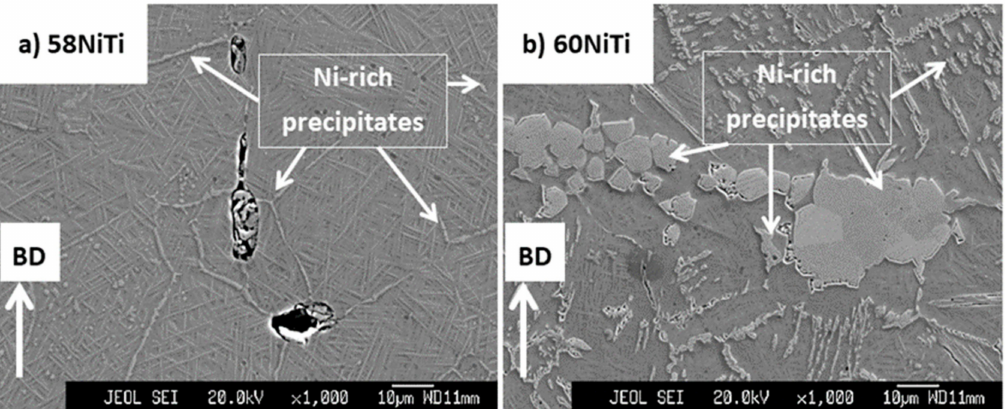
Figure 7. Images obtained from the cross-section of HIP-treated (at 1050 ◦ C for 4 h under an applied pressure of 180 MPa) samples being printed from ( a ) 58 wt.% Ni + 42 wt.% Ti and ( b ) 60 wt.% Ni + 40 wt.% Ti powders mixtures. Microstructures complying with those of ( a ) 58NiTi and ( b ) 60NiTi, respectively, were obtained as a result of this treatment. Some of the Ni 3 Ti and Ni 3 Ti 2 Ni-rich phases seen in the microstructure of these samples are shown in the